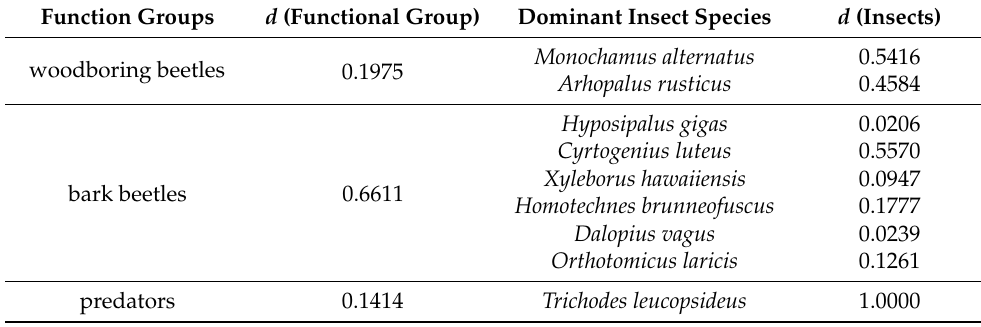
Table 1. Function groups of insects and their dominance index ( d ) in P. thunbergii Parl.